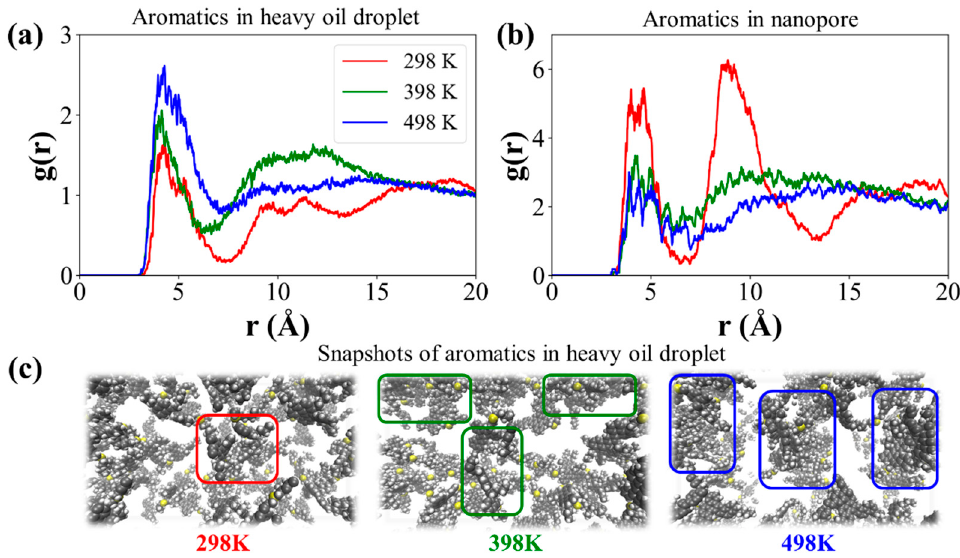
Figure 8. RDFs of aromatic molecule pairs in ( a ) heavy oil droplet and ( b ) nanopore at 298 K, 398 K, and 498 K, respectively, ( c ) the snapshots of aromatic molecules in heavy oil droplet at 298 K, 398 K, and 498 K, respectively.